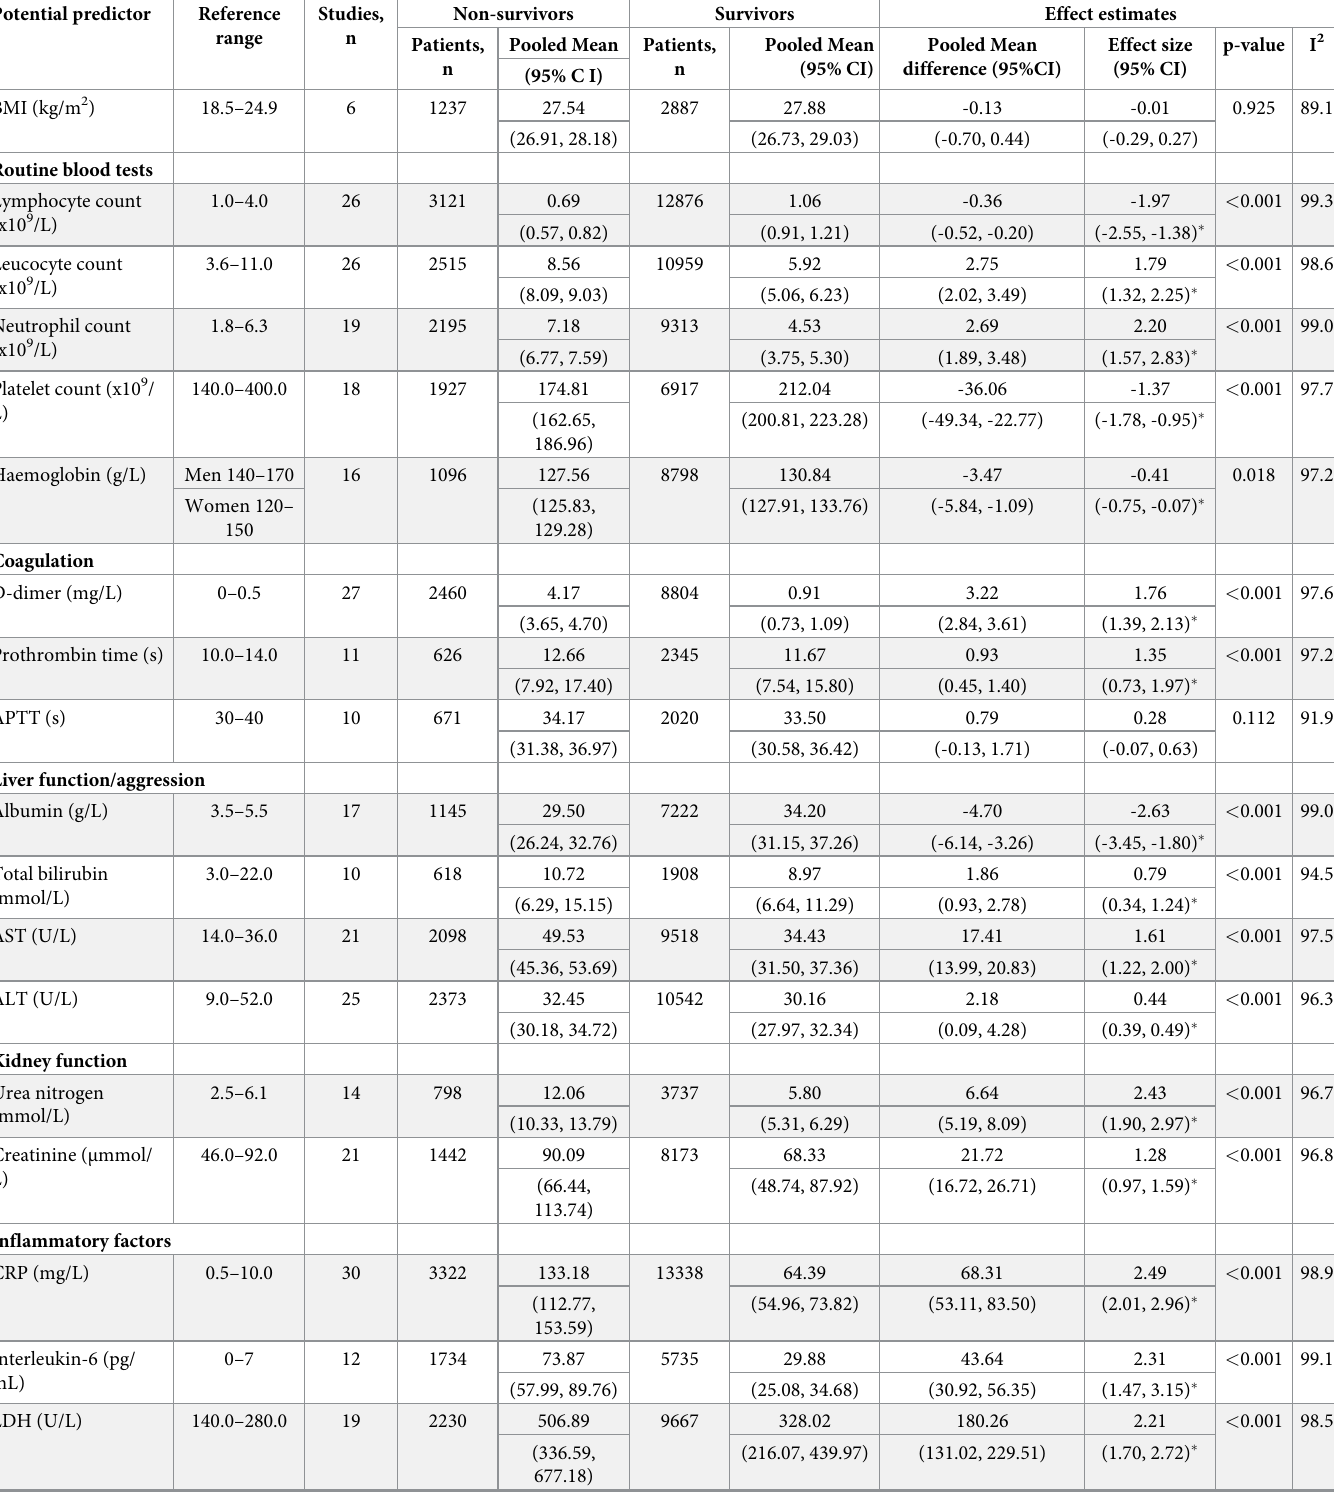
Table 3. Meta-analyses of body mass index and laboratorial potential predictors of in-hospital